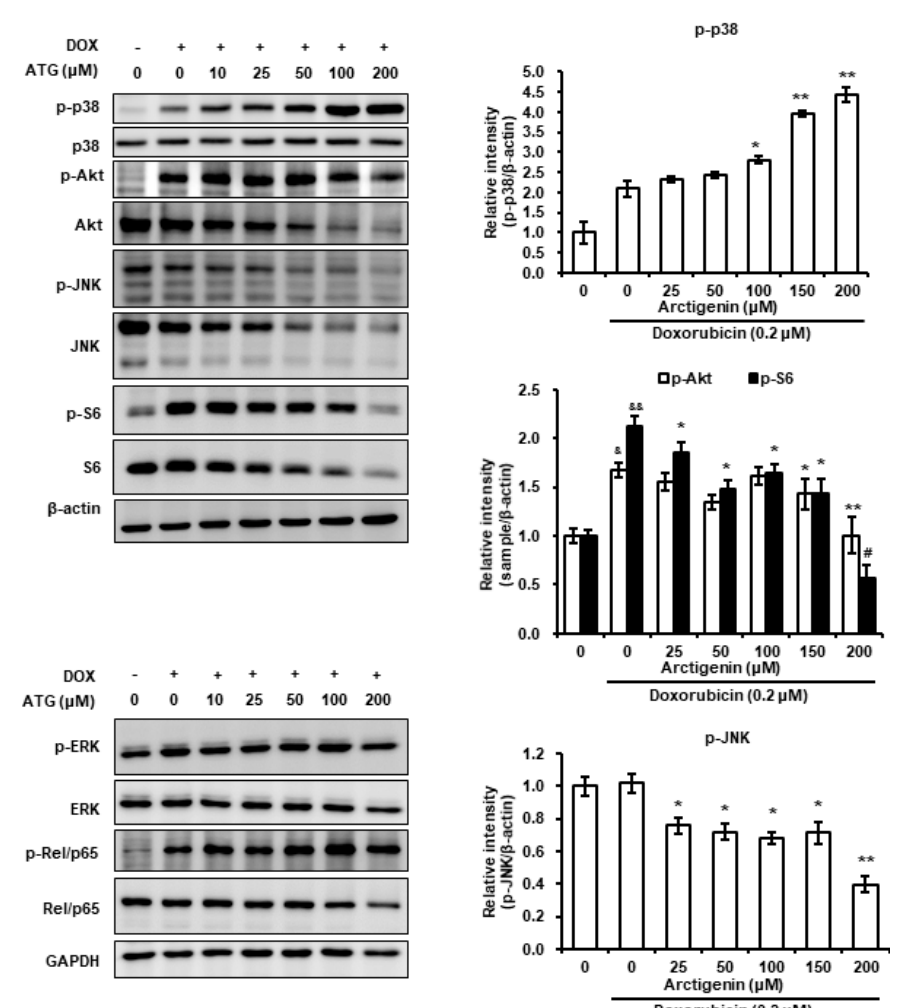
Figure 7. Effects of ATG/DOX co-treatment on the phosphorylations of Akt, mitogen-activated protein kinases (MAPKs), S6 and NF- κ B in MDA-MB-231 cells. Cells were attached for 24 h and then co-treated with 0.2 μ M DOX and various concentration of ATG (0–200 μ M) for 72 h in DMEM medium supplemented with 2% FBS. Phosphorylated p38 levels induced by DOX were concentration-dependently increased by ATG. In contrast, DOX-induced phosphorylation of S6 was prevented by ATG. ATG/DOX co-treatment reduced the phosphorylations of Akt and JNK. Proteins in whole cell lysates, nuclear fractions, and cytosolic factions were separated by 8% or 10% SDS-PAGE and transferred to PVDF membranes. Bands in nuclear and cytosolic fractions were densitometrically analyzed using Scion Image software and band densities were normalized versus GAPDH. & and && indicate p < 0.05 and p < 0.01 vs. non-treated controls. *, ** and # indicate p < 0.05, p < 0.01, and p < 0.001 vs. DOX treated cells. All experiments were conducted independently three times, and the results are presented as means ± SDs. –: 0.2 μ M DOX-untreated, +: 0.2 μ M DOX-treated